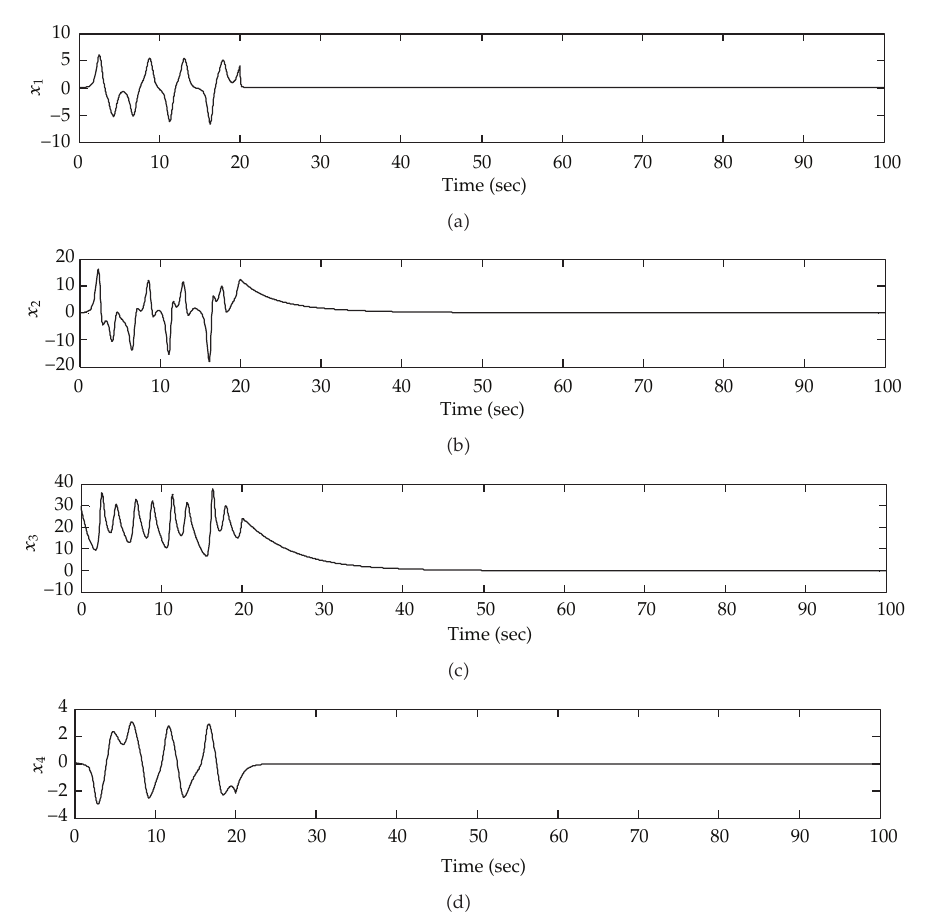
Figure 2: The state responses of the controlled 4D Lorenz-Stenflo chaotic